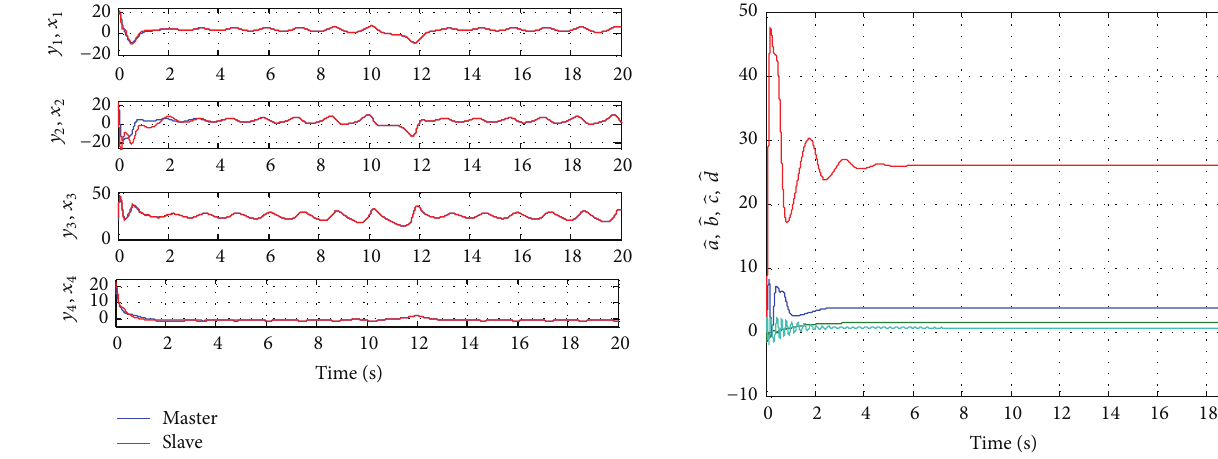
Figure 2: Time histories of the master system and slave system for Case I.